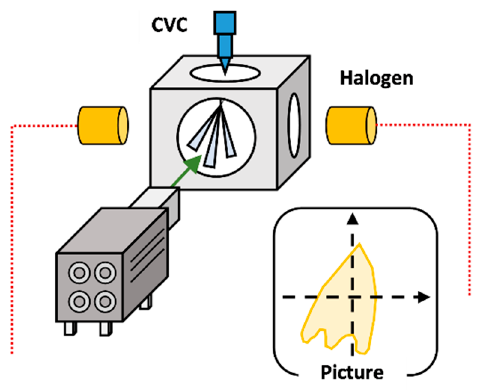
Figure 3. Schematic of fuel atomization tests using halogen lighting—longitudinal projection view of fuel spray.